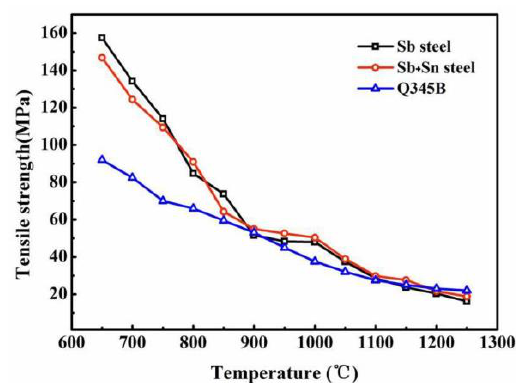
Figure 5. Thermal strength curve.